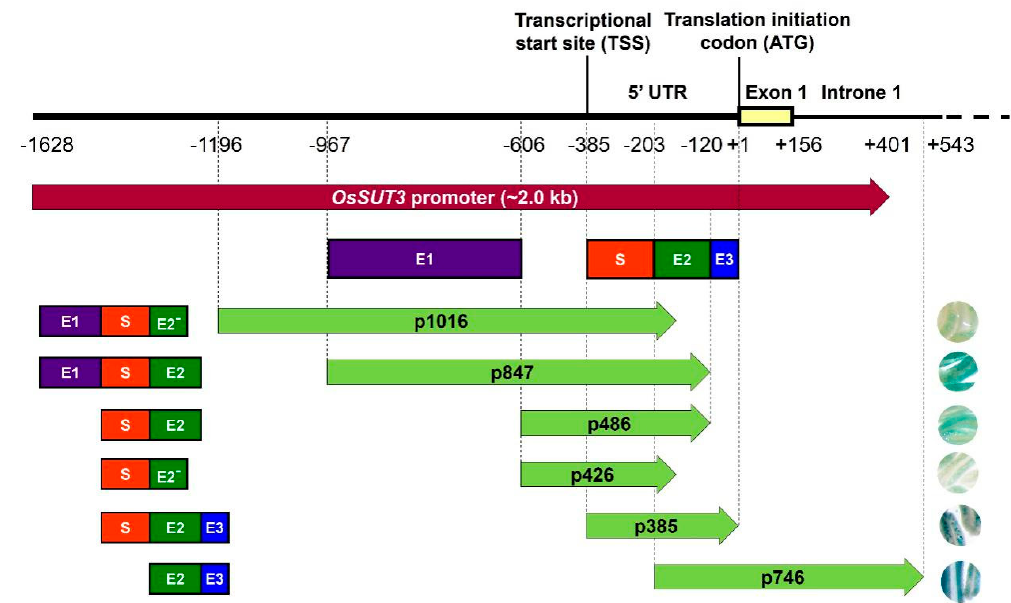
Figure 3. Contribution of four regions from pOsSUT3 to the expression of the GUS reporter gene in pollen. Purple rectangle, enhancer region 1 (E1); dark green rectangle, enhancer region 2 (E2); blue rectangle, enhancer region 3 (E3); red rectangle, specific expression region (S). E2 − represents the 5 ′ part of the E2 deleted 60 bp at the 3 ′ end. The frameworks of rectangular structures on the left of the arrowed rectangle represent the functional regions contained in various promoter deletions. The right circles represent the staining strength of GUS in pollen from transformant lines carrying different promoter fragments.